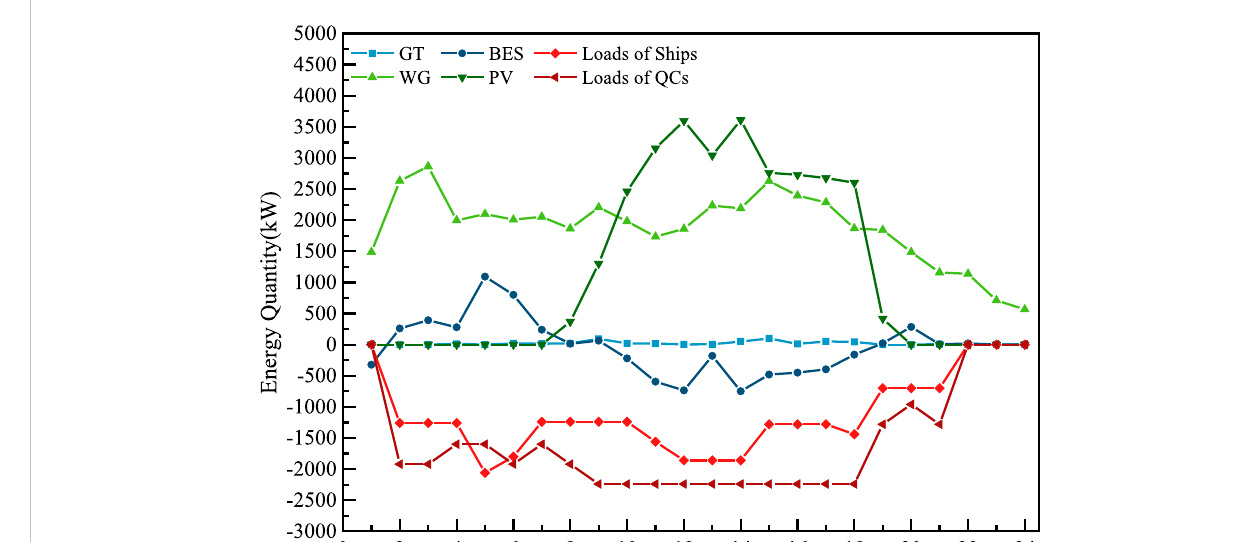
FIGURE 6 Power dispatching